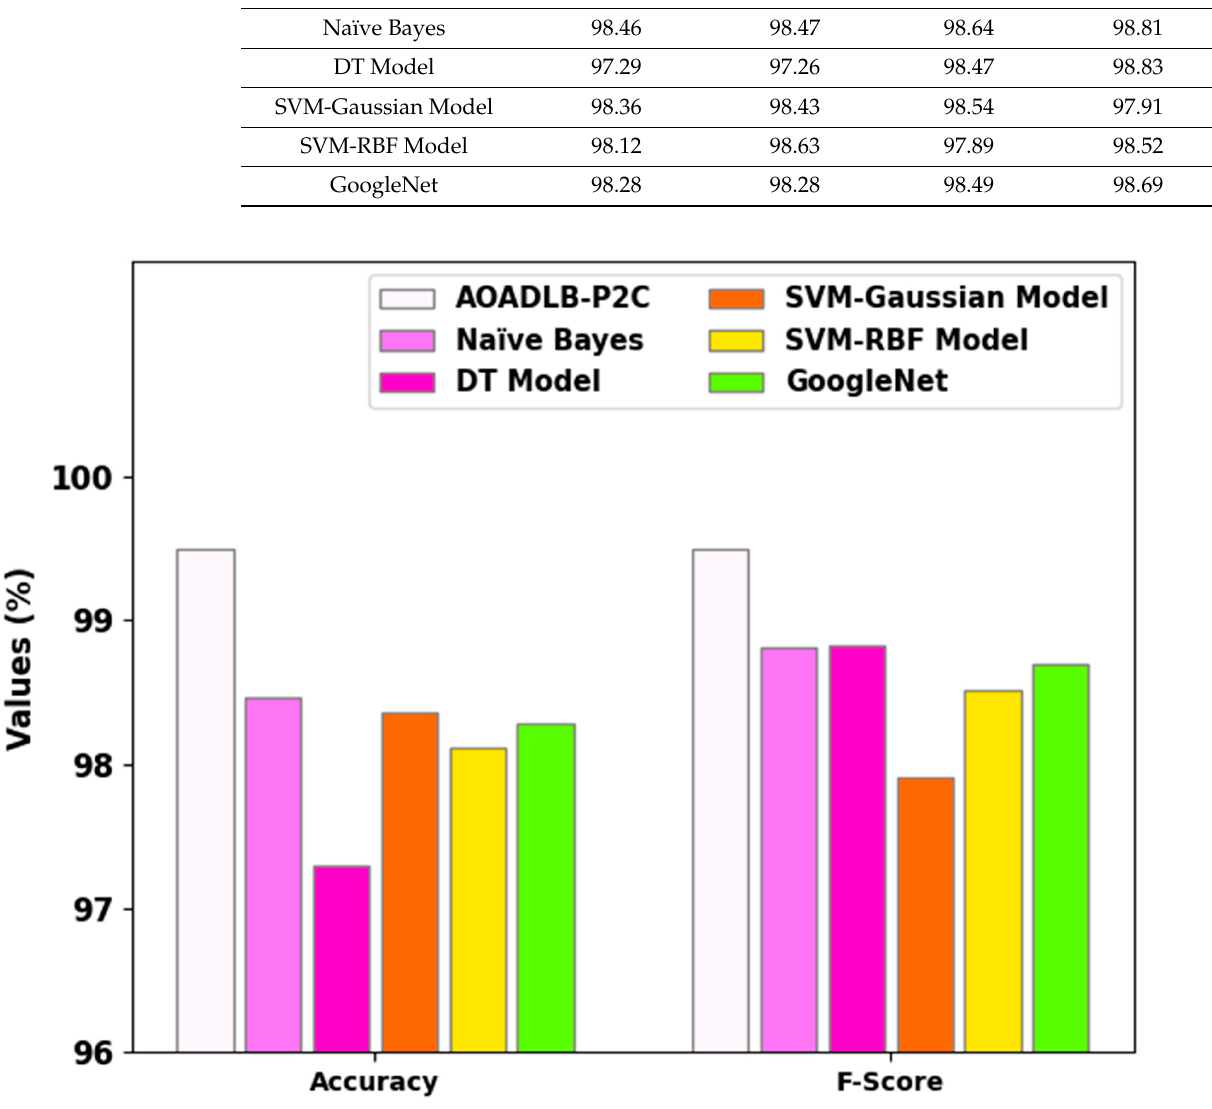
Figure 8. 𝐴𝑐𝑐𝑢 (cid:3052) and 𝐹 (cid:3046)(cid:3030)(cid:3042)(cid:3045)(cid:3032) analytical results of the AOADLB-P2C system and other recent ap- Figure 8. Accu y and F score analytical results of the AOADLB-P2C system and other recent proaches.